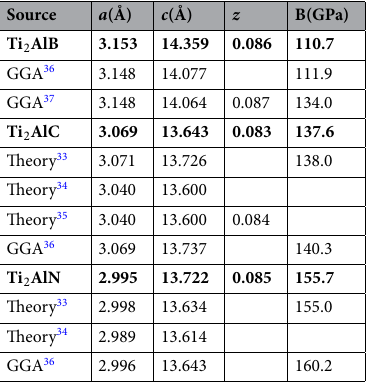
Table 4. Structural properties of Ti 2 AlX (X: B, C and N) for this work in bold, and their comparison with previous theoretical results.